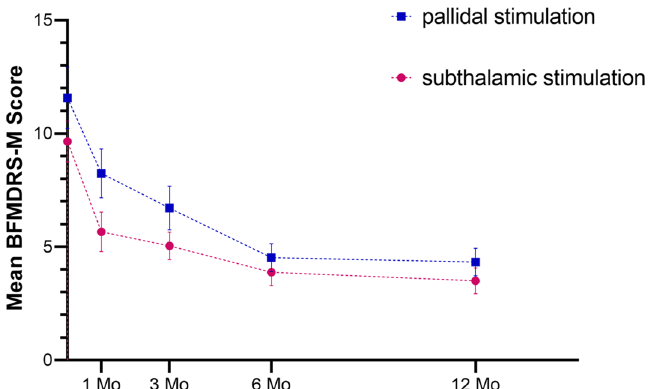
Figure 1. Burke–Fahn–Marsden Dystonia Rating Scale movement subscale scores (BFMDRS-M; scores range from 0 to 40, with higher scores indicating greater impairment) at baseline and throughout the 12-month study period. The changes in the BFMDRS-M scores at 1, 3, 6, and 12 months with deep-brain stimulation and without medication did not significantly differ based on the stimulation target. I bars indicate the standard error of the mean.